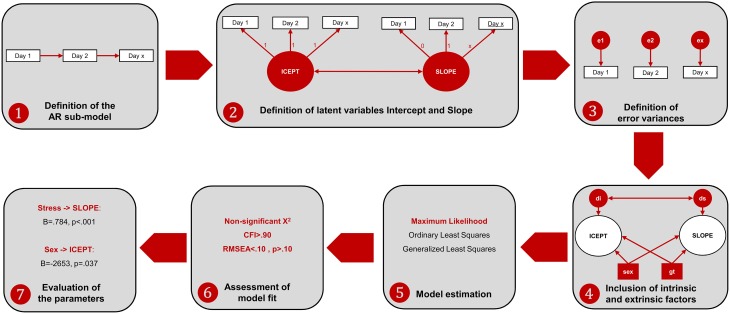
Workflow of the ALT approach specification and interpretation. (1) The AR sub-model is established by specifying relationships between consecutive time-points; (2) the variables Intercept and Slope are defined to represent baseline levels (each time-point has the same weight) and linear growth (each time-point has an increase of one-unit comparing to the previous time-point). Additionally, a correlation between Intercept and Slope is established to test whether animals that are better performers at the baseline are those with higher growth learning curves; (3) the variance not explained by neither the intercept nor the slope is specified as error variance (which is also a latent measure); (4) internal and external individual characteristics are included to assess their influence in the intercept and in the slope. Two latent variables are defined to account for the error variance of the intercept (disturbance of the intercept, di) and the slope (disturbance of the slope, ds); (5) the model is estimated with one estimation method (the maximum likelihood is the most often used in the ALT approach); (6) the fit of the model is assessed through the analysis of different indices [as previously mentioned, the chi-square together with incremental (such as the CFI) and another absolute fit indices (such as the RMSEA) should be evaluated]. In the case of poor model fit, the model should be re-specified, making some adjustments (e.g., including non-linear growth variables, such as quadratic or logarithmic growth functions); (7) the parameters are evaluated to assess the relevant associations between variables.